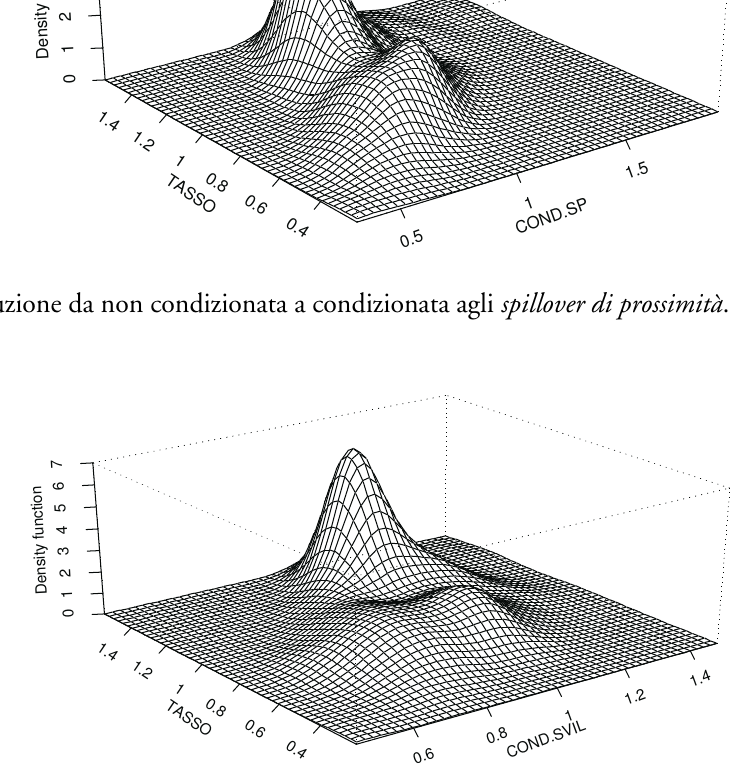
Figura 7 – Evoluzione da non condizionata a condizionata allo sviluppo strutturale